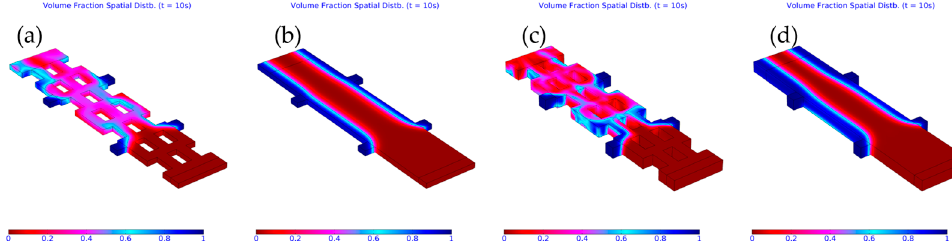
Figure 20. Three ‐ dimensional snapshots of mixing chambers with a length of 0.21 m and two plasma inlets having a thickness of 1 × 10 − 2 m: ( a ) with obstacles; and ( b ) without obstacles; and having a thickness of 2 × 10 − 2 m: ( c ) with obstacles; and ( d ) without obstacles.